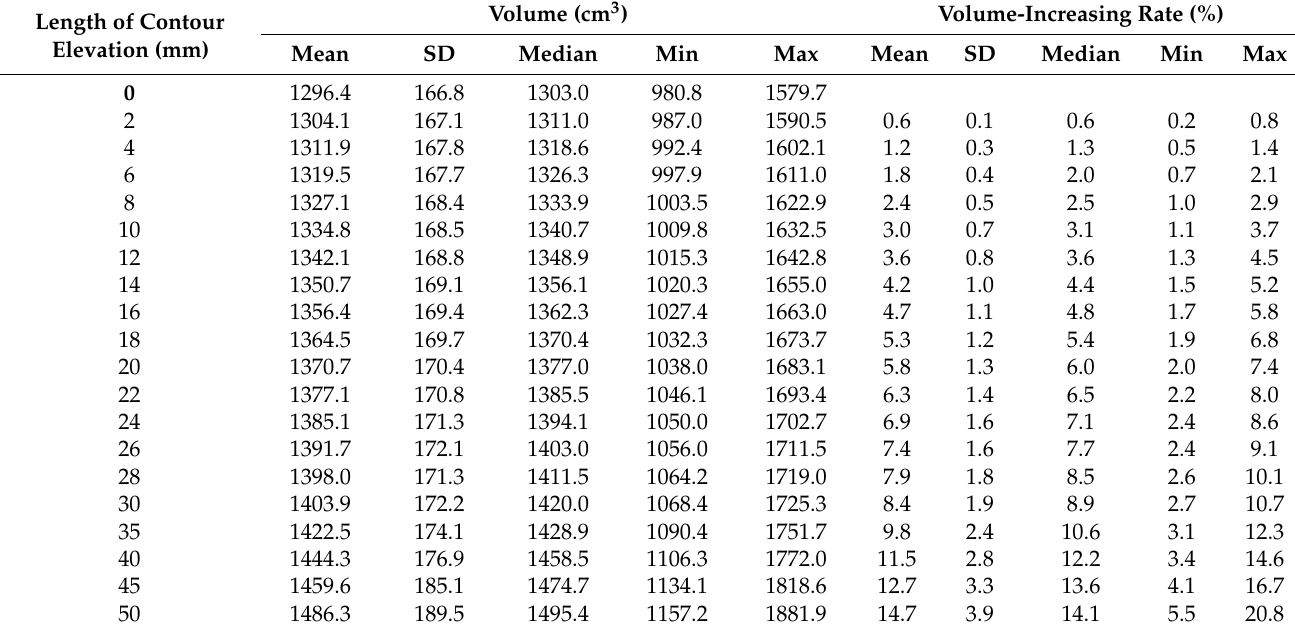
Table 2. Parameter description of 15 CAD